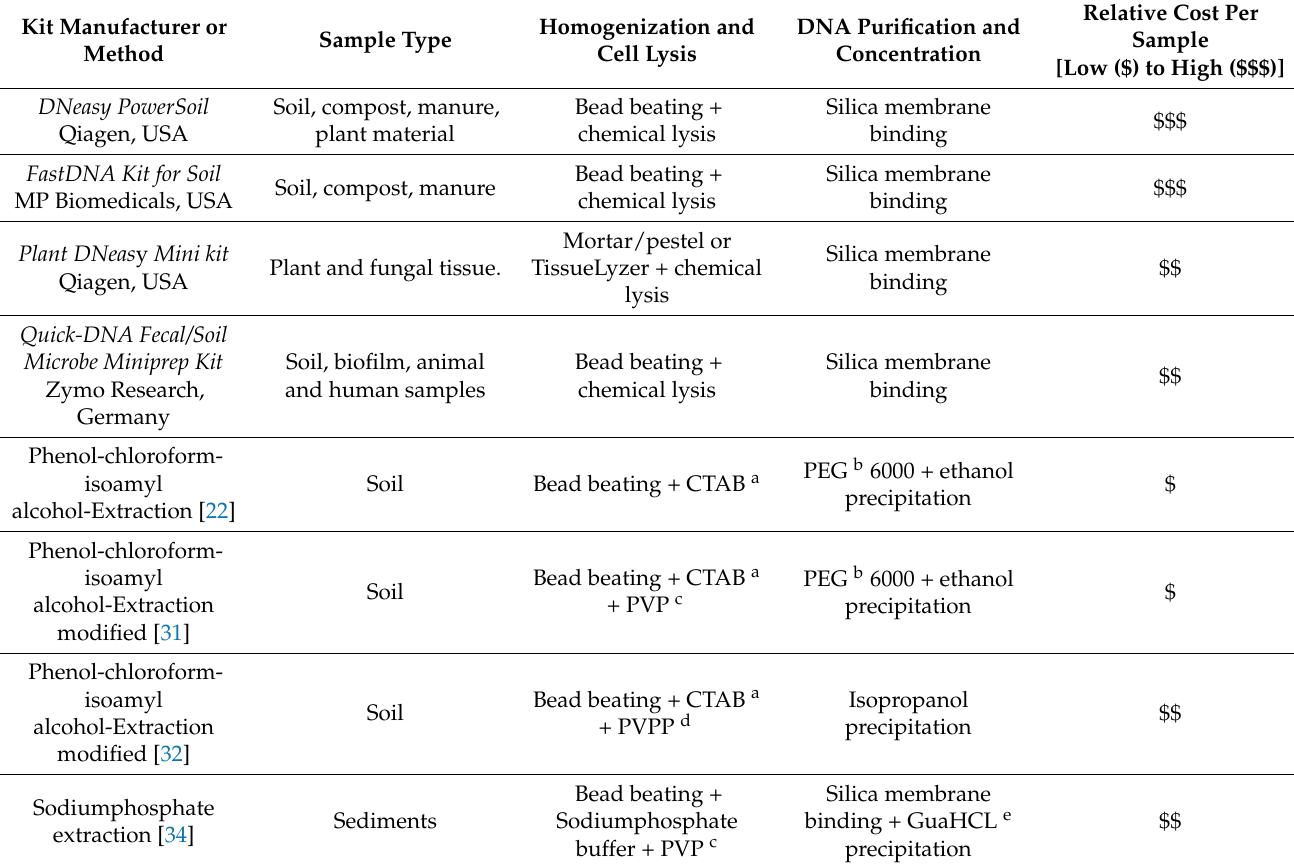
Table 1. Commonly used DNA extraction kits and methods for soil and plant-associated